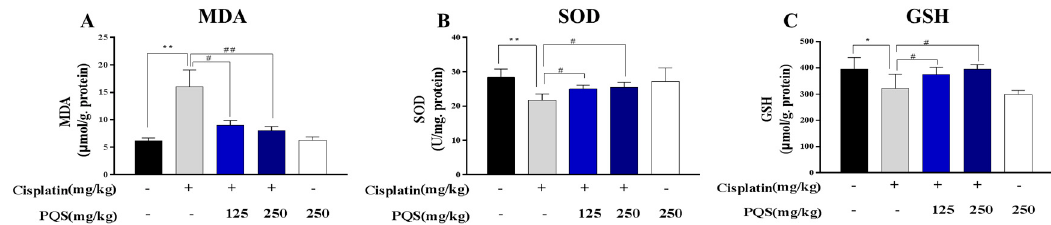
Figure 3. Effects of PQS on the levels of ( A ) MDA, ( B ) glutathione (GSH) and ( C ) superoxide dismutase (SOD). All data were expressed as mean ± S.D. * p < 0.05 or ** p < 0.01 comparing with normal group. # p < 0.05 or ## p < 0.01 comparing with cisplatin group.